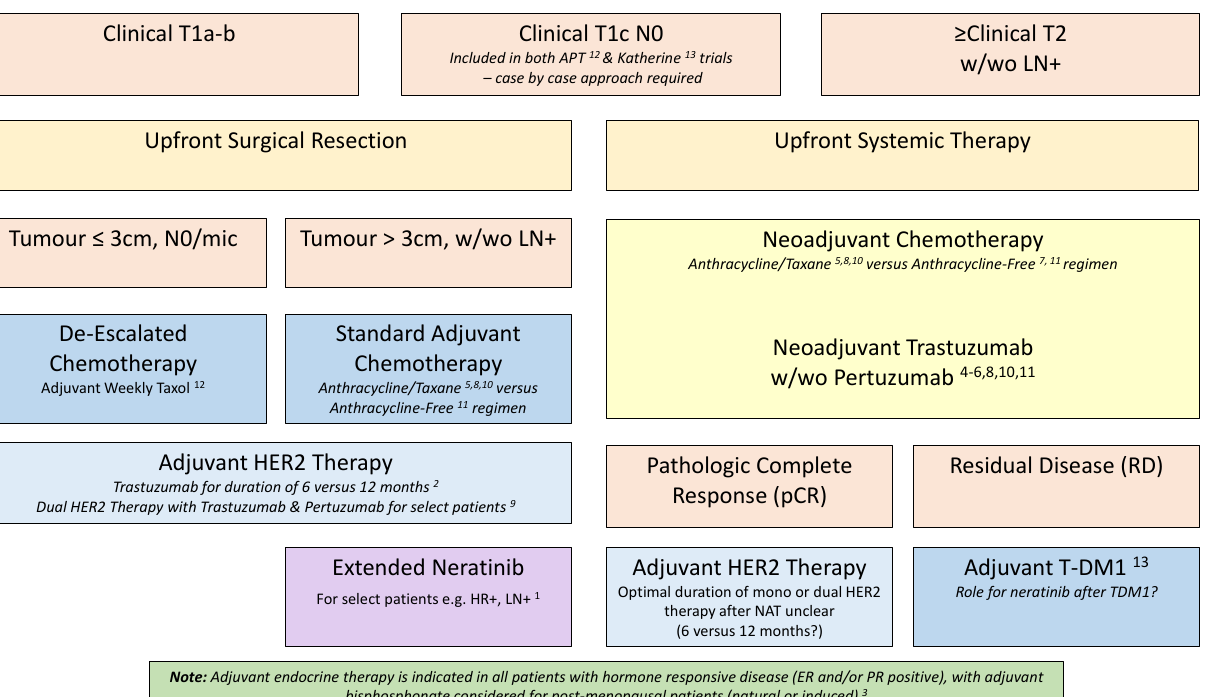
Figure 1. Current evidence-based risk tailored approach to HER2-positive EBC. EBC: early breast cancer; ER: estrogen receptor; HR: hormone receptor; LN: lymph node; NAT: neoadjuvant therapy; PR: progesterone receptor; w/wo: with/without. References: 1 [19]; 2 [19]; 3 [43]; 4 [32]; 5 [3]; 6 [5]; 7 [43]; 8 [1]; 9 [6]; 10 [2]; 11 [4]; 12 [21]; 13 [47].